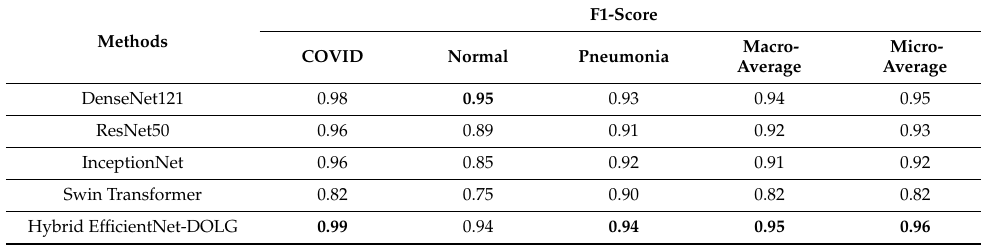
Table 6. Comparing results between the five deep learning models on the COVID-19 classification task with respect to F1-score